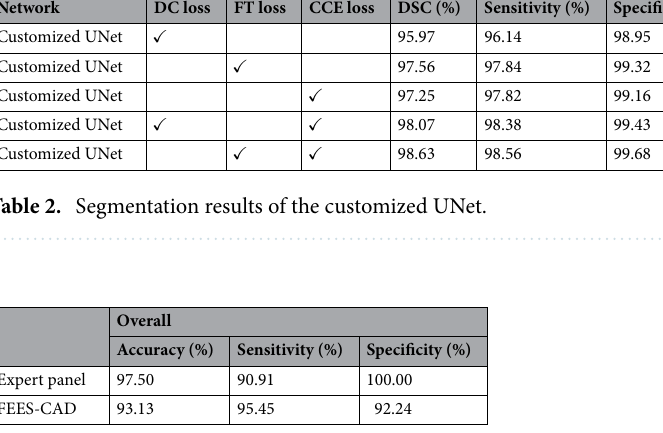
Table 3. Comparison between FEES-CAD and expert panel on the overall